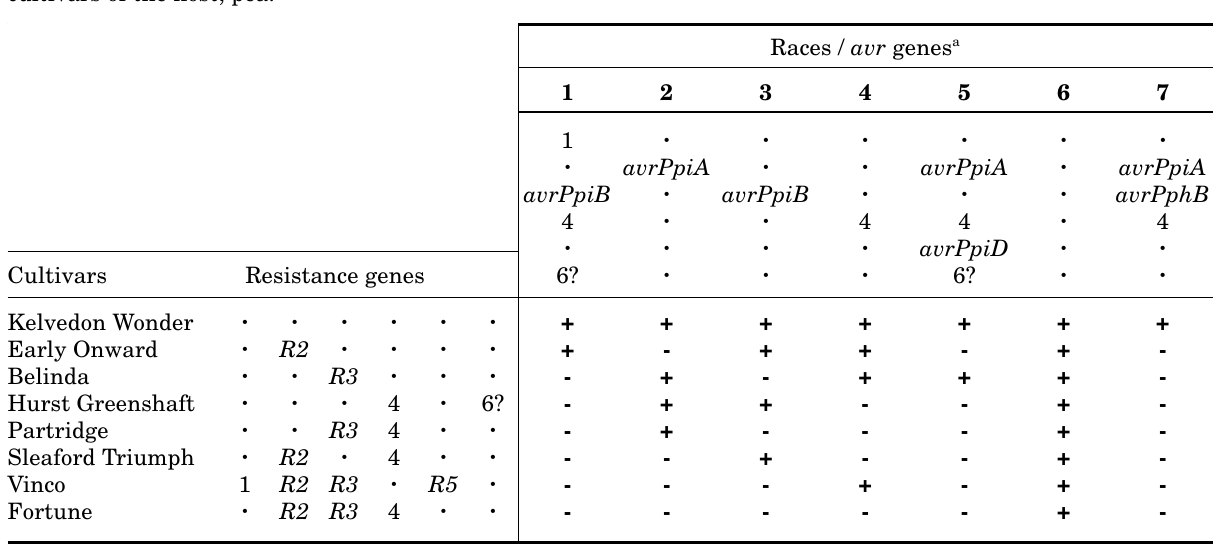
Table 7. Partly validated model to explain observed interactions between races of Pseudomonas syringae pv. pisi and cultivars of the host,